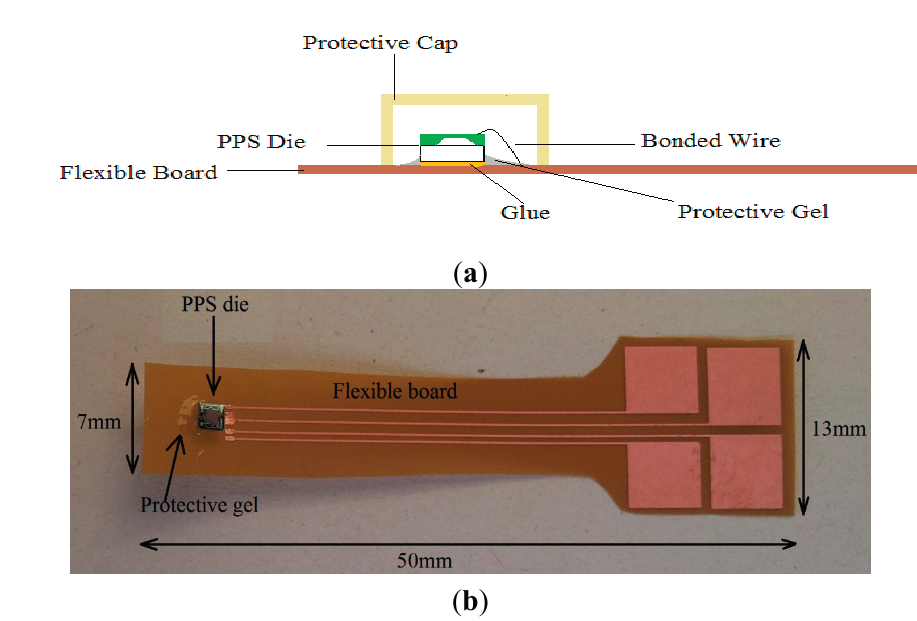
Figure 4. ( a ) Schematic and ( b ) a photograph of the glued piezoresistive pressure sensor (PPS) die on a flexible